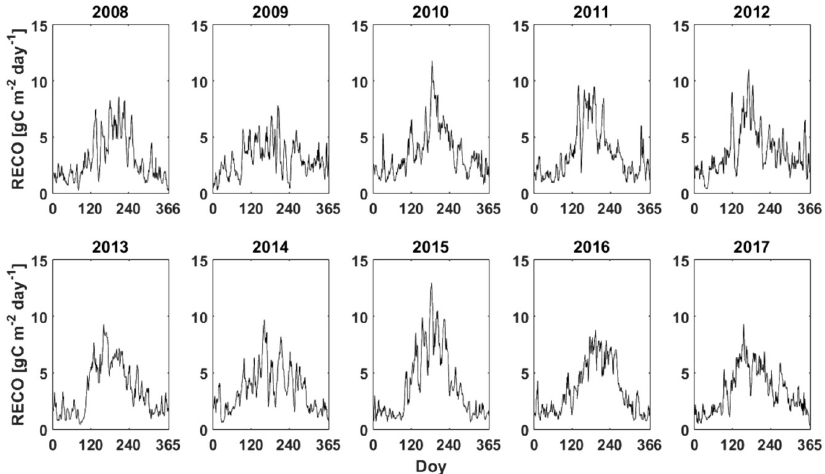
Figure 8. Daily values of R ECO in Jastrebarsko forest during 2008–2017.